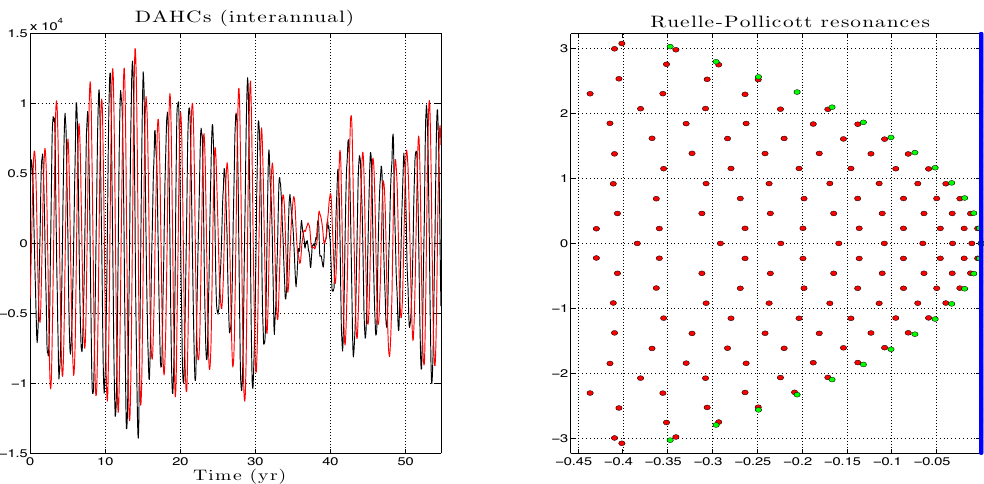
Figure A2. Reduced RP resonances and their analytic approximation. Left panel: The pair of DAHCs analyzed. Right panel: Corresponding eigenvalues of P as estimated by using (A7), after application of the logarithm (in red). The blue vertical line corresponds to the imaginary axis. These eigenvalues correspond to approximations of the point spectrum of the averaged Fokker–Planck operator given in (A8). The analytic approximations provided by (A17) are shown as green